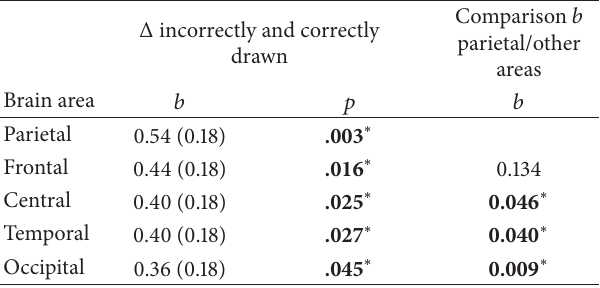
Table 3: Correlation between alpha/theta ratio and Clock Drawing